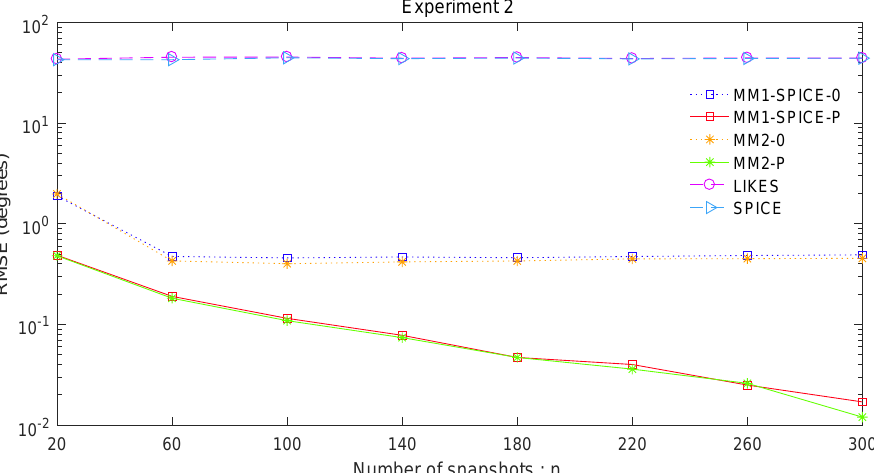
Figure 3. DOA estimation RMSE versus SNR for Experiment 3.